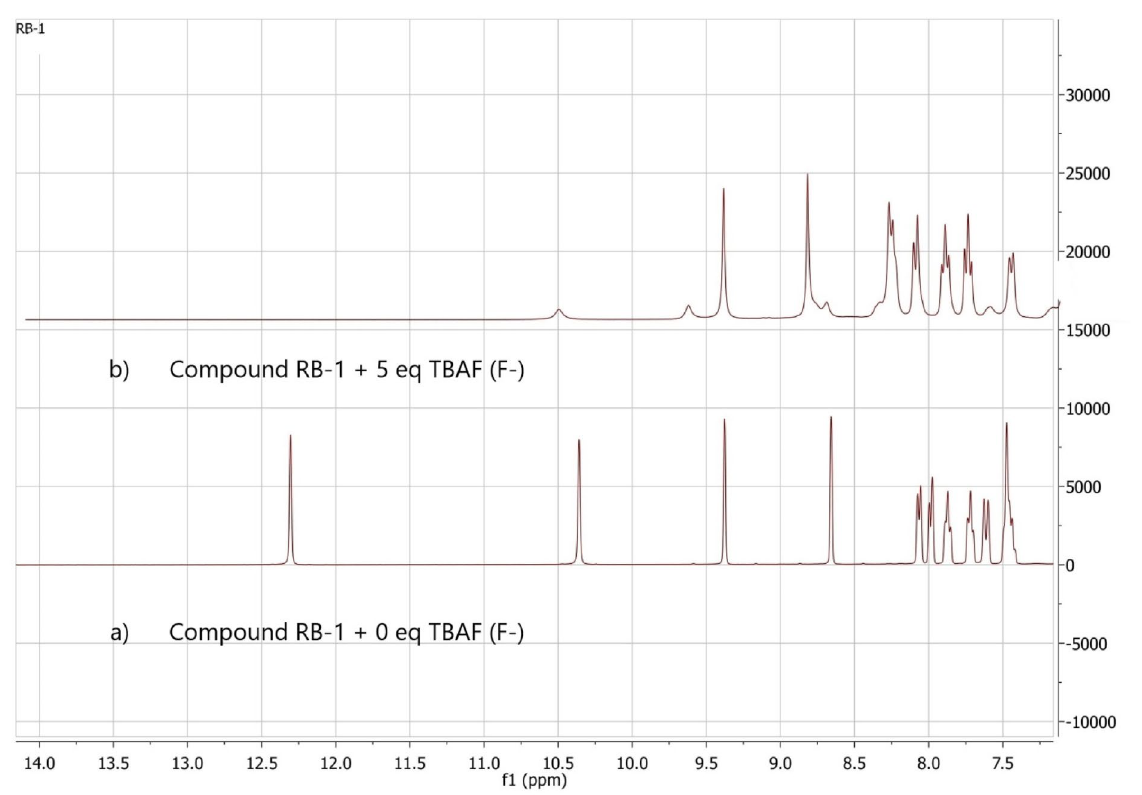
Figure 7. Study of 1 H-NMR spectra of (RB-1) on addition of Fˉ ions a) no Fˉ ions addition b) 5 equiv. addition in DMSO-d 6 as